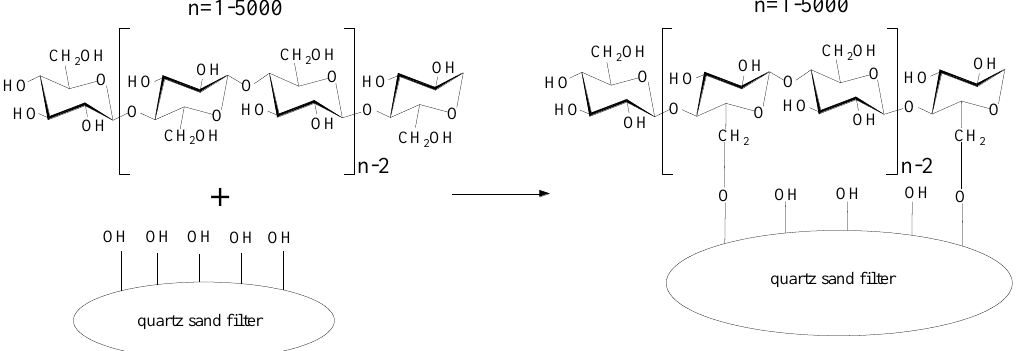
Figure 3. Schematic diagram of preparing make coconut shell powder-covered quartz sand filter media (CSQS).